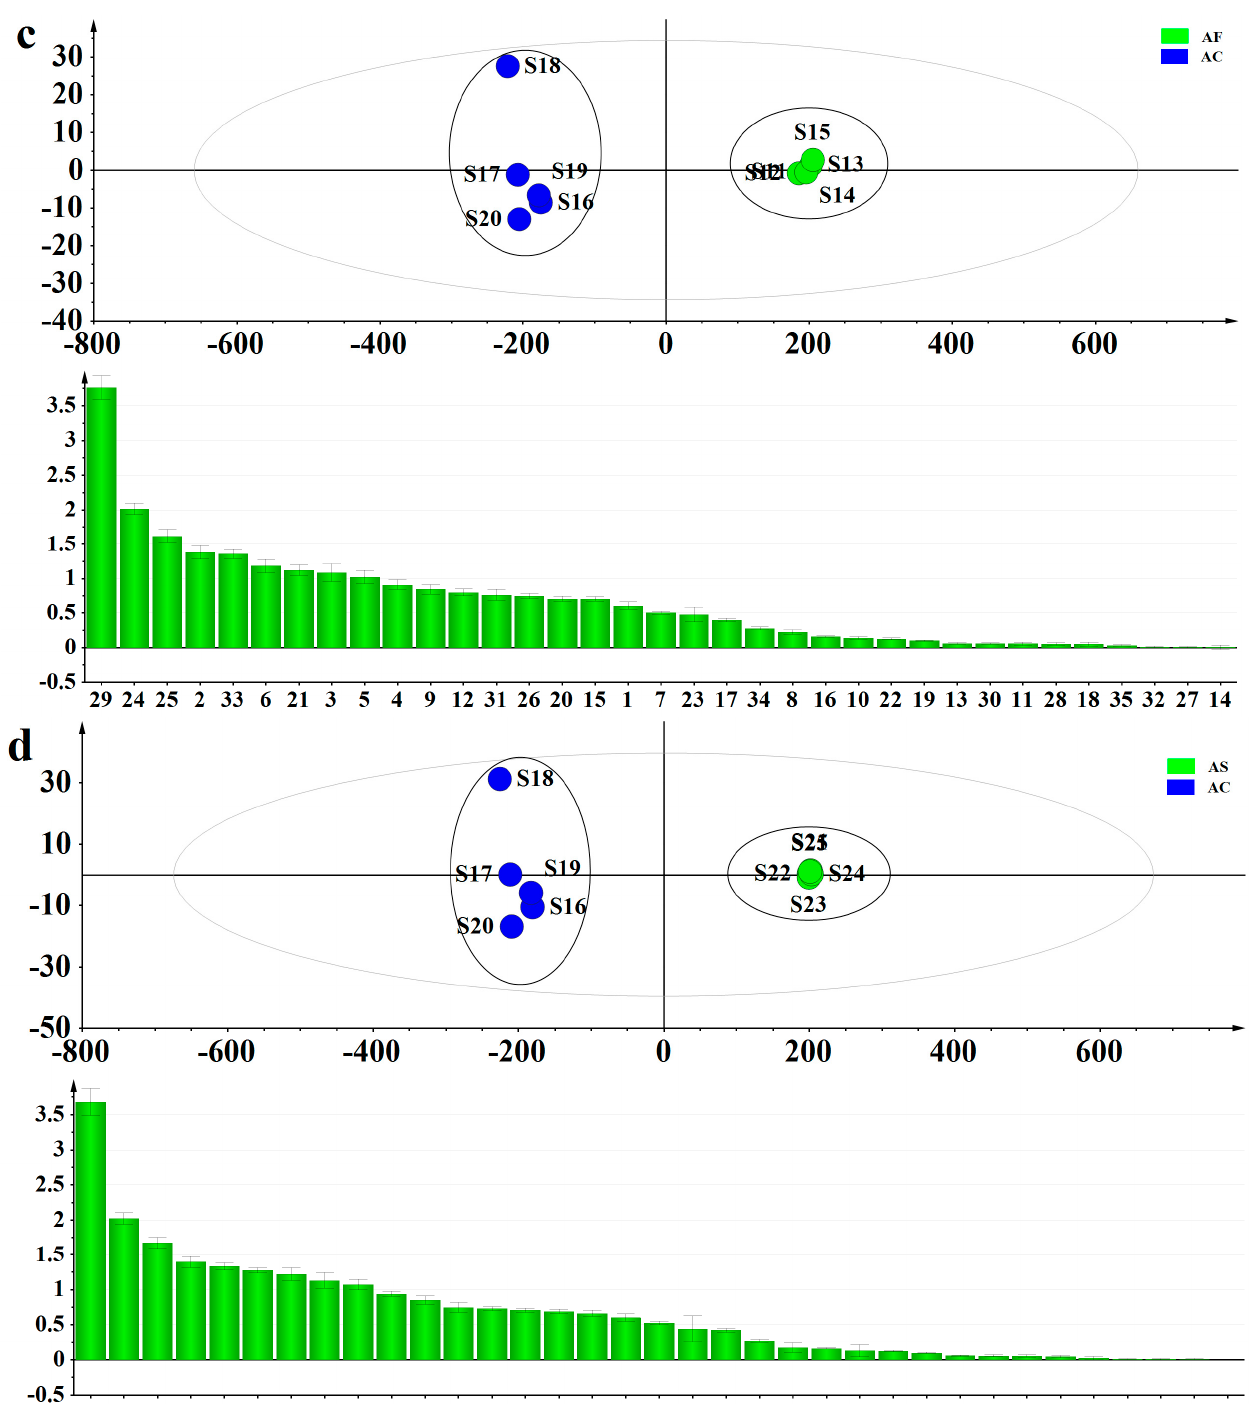
Figure 4. The partial least squares discriminant analysis (PLS-DA) score scatter plot and variable importance in the projection (VIP) of Abelmoschi Radix (AR) and Abelmoschi Corolla (AC) ( a ), Abelmoschi Herba (AH) and AC ( b ), Abelmoschi Folium (AF) and AC ( c ), Abelmoschi Semen (AS) and AC ( d ).